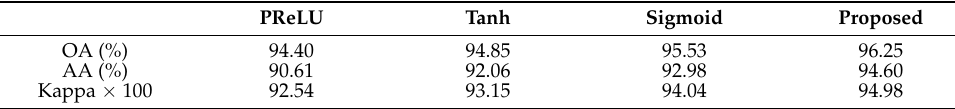
Table 10. Influence of different activation functions.